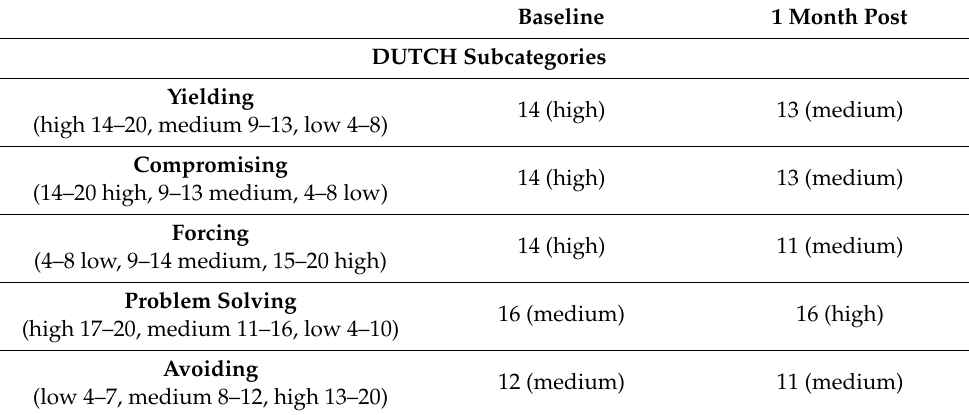
Table 1. Changes in negotiation skills post negotiations and dispute resolution (NDR)